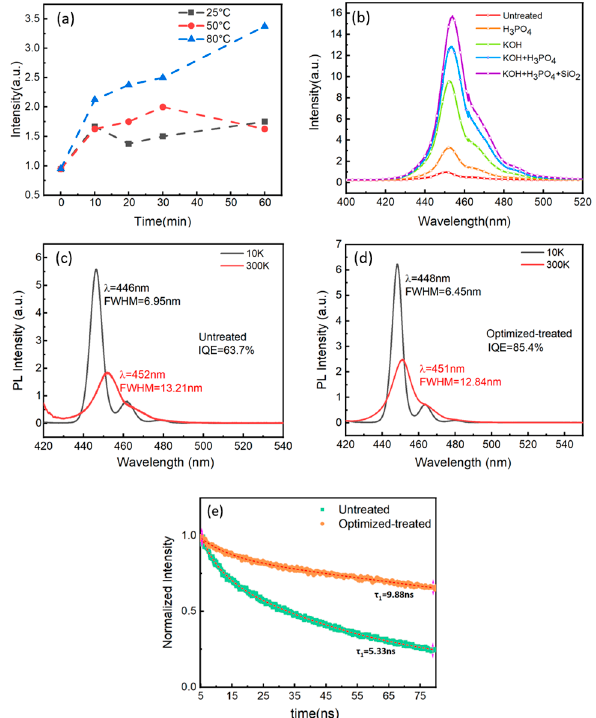
Figure 2. ( a ) Statistics of PL intensity of Micro-LEDs treated by different parameters; ( b ) PL spectra of Micro-LEDs sample S1 to S5; ( c ) TDPL spectra and IQE of untreated sample S1; ( d ) TDPL spectra and IQE of optimized-treated sample S5; ( e ) TRPL of sample S1 and sample S5.